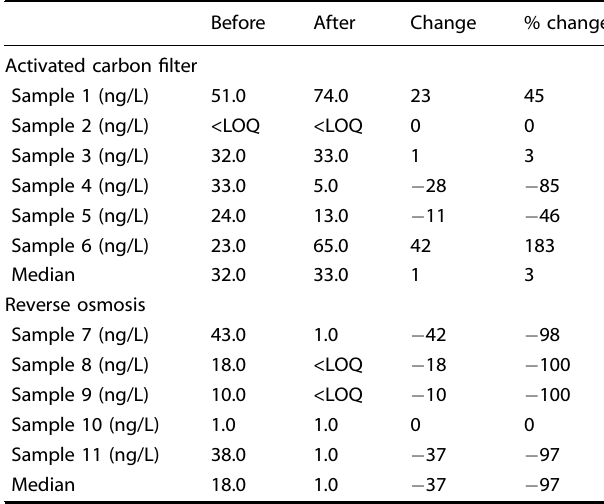
Table 2. Total PFAS concentrations (ng/L) in tap water samples before and after using domestic fi lters.